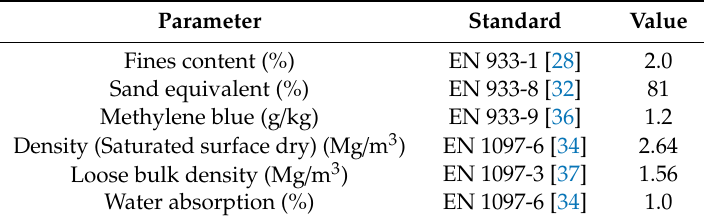
Table 2. Fine aggregate characteristics.